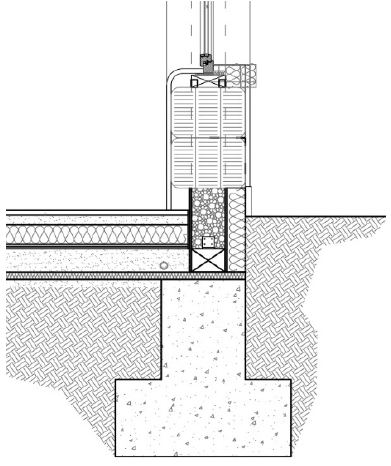
Figure 12. Details of the foundations.